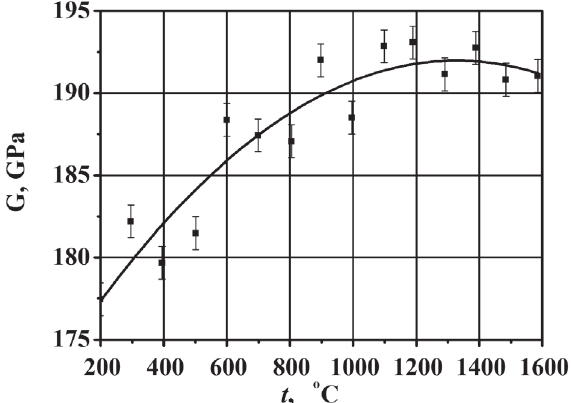
Figure 7. Dependence of the shear modulus of the irradiated rhenium samples on the isochronous annealing temperature.